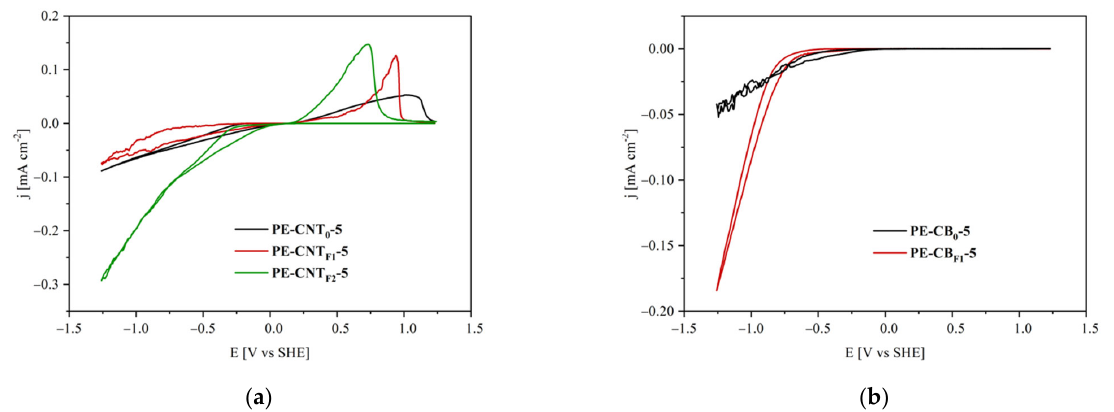
Figure 5. Cyclic voltammograms of PE ‐ CNT 0 ‐ 5, PE ‐ CNT F1 ‐ 5, PE ‐ CNT F2 ‐ 5 ( a ) and PE ‐ CB 0 ‐ 5, PE ‐ CB F1 ‐ 5 ( b )